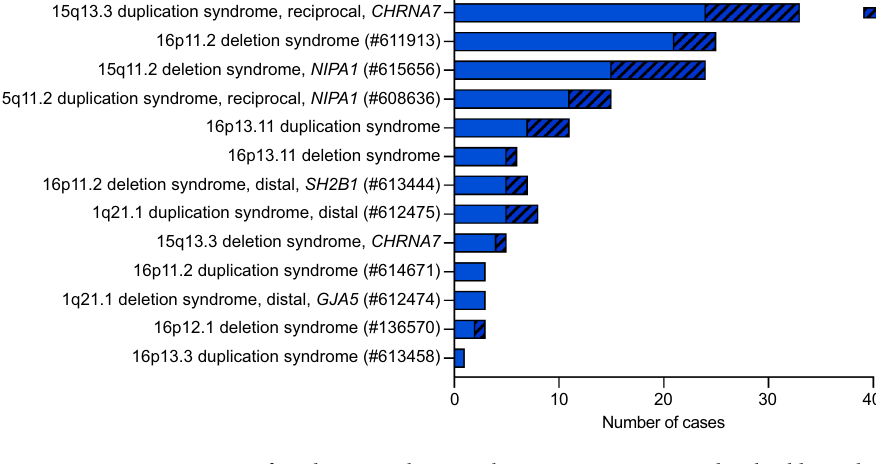
Figure 5. Frequency of syndromes with incomplete penetrance associated with additional variants. The histogram shows the frequency of a secondary CNV associated with a syndrome with incomplete penetrance.